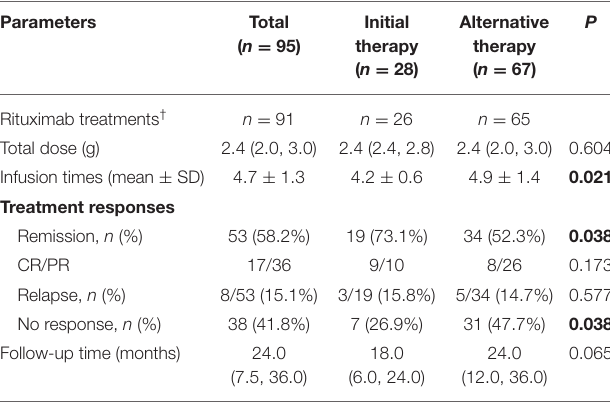
TABLE 2 | Details of rituximab therapy and